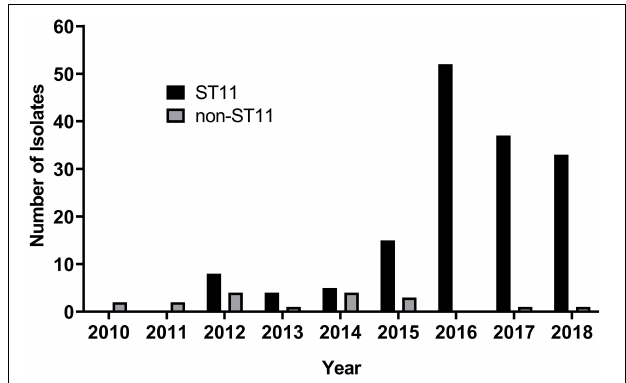
FIGURE 1 | The number of Klebsiella pneumoniae carbapenemase-2 (KPC-2) producing carbapenem-resistant K. pneumoniae (CRKP) strains isolated each